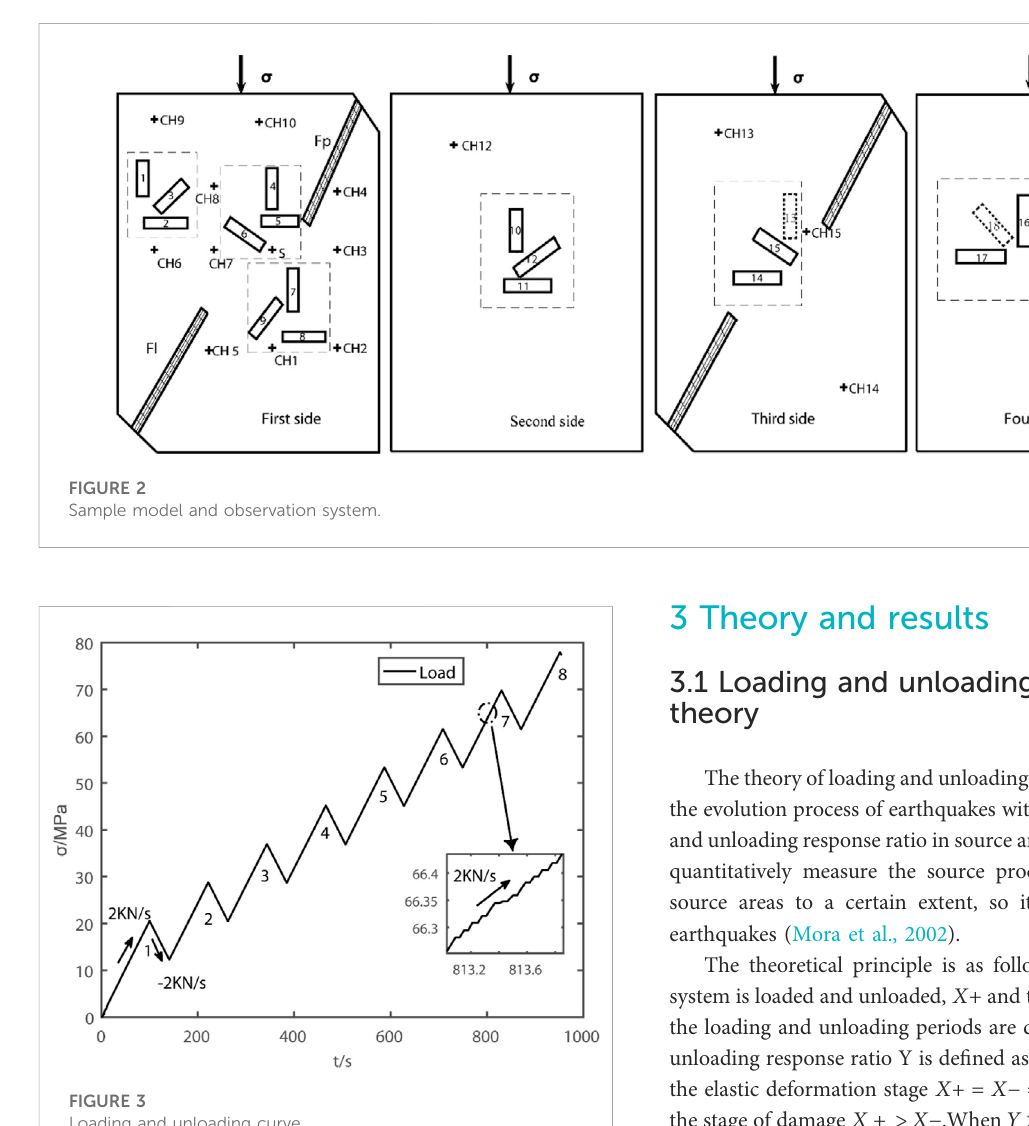
FIGURE 3 Loading and unloading